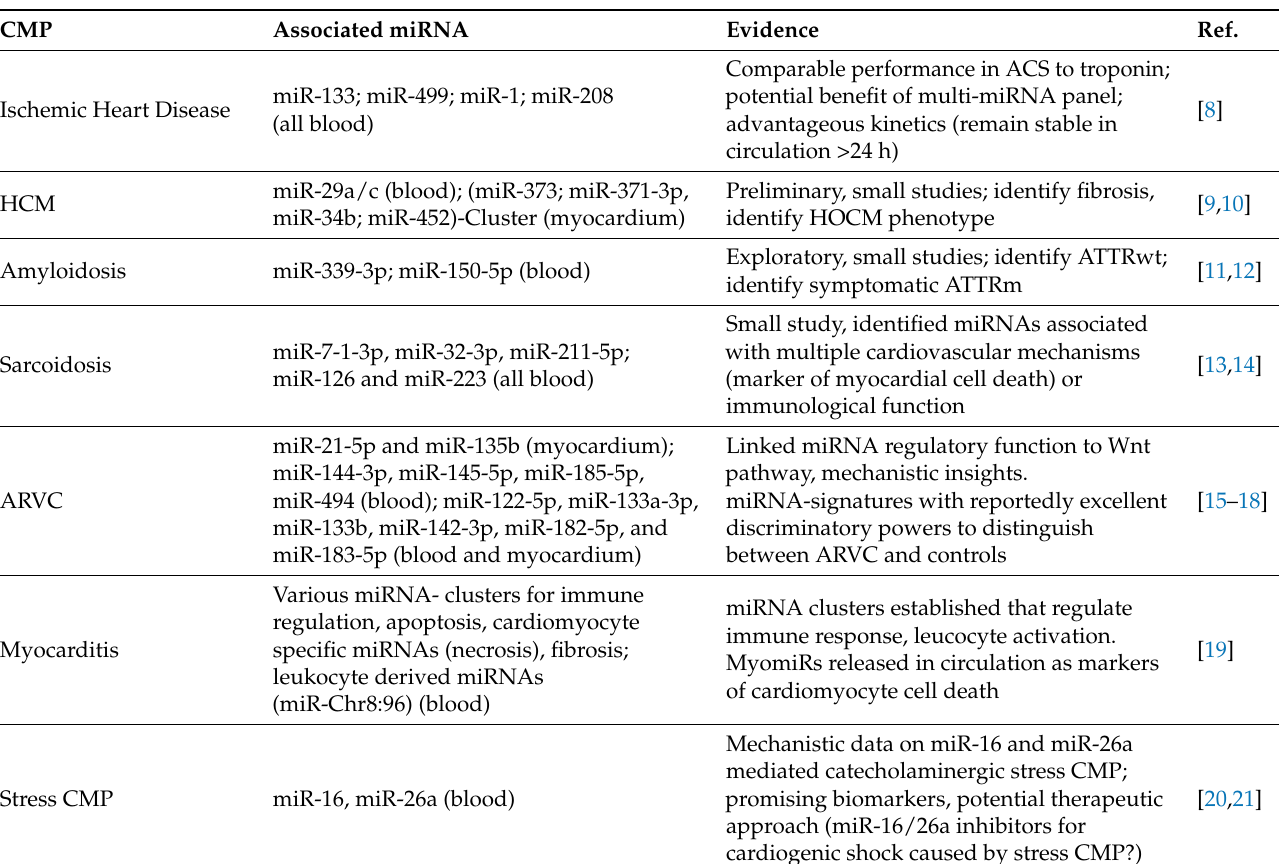
Table 1. Potential miRNA-based biomarkers for heart disease. Evidence